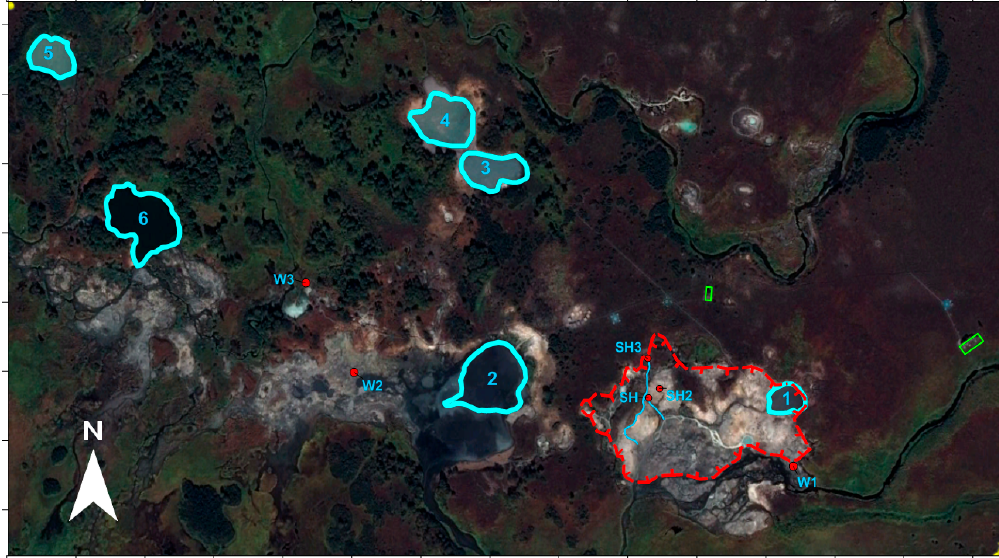
Figure 2. Shaman geyser area. Air-photo (Google Earth, 19 September 2017) scheme of the East Uzon thermal field, where geyser Shaman is located. SH—Shaman geyser ( Figures A 1–8 in Appendix), SH2—hot CO 2 spring adjacent to geyser ( Figure A 11 in Appendix), SH3–hot spring where warm– the Shaman geyser conduit ( Figure A 6). Diatreme shapes: 1—Bannoe Lake ( Figure A 9 in Appendix);